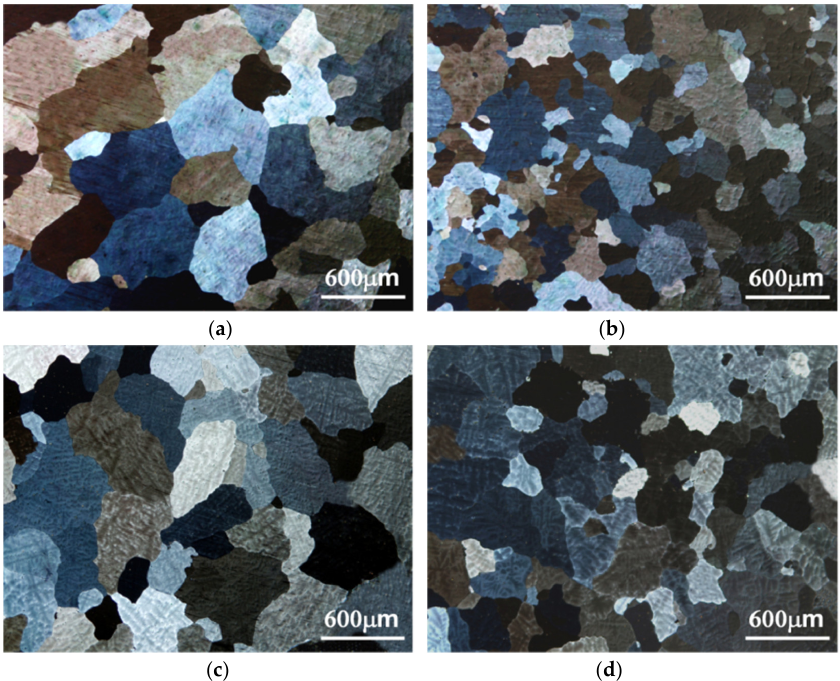
Figure 3. Optical photomicrographs of as-cast ( a ) alloy A (Al-Mg alloy), ( b ) alloy B (Al-Mg-Mn alloy), ( c ) alloy C (Al-Mg-Zn alloy) and ( d ) alloy D (Al-Mg-Mn-Zn alloy).